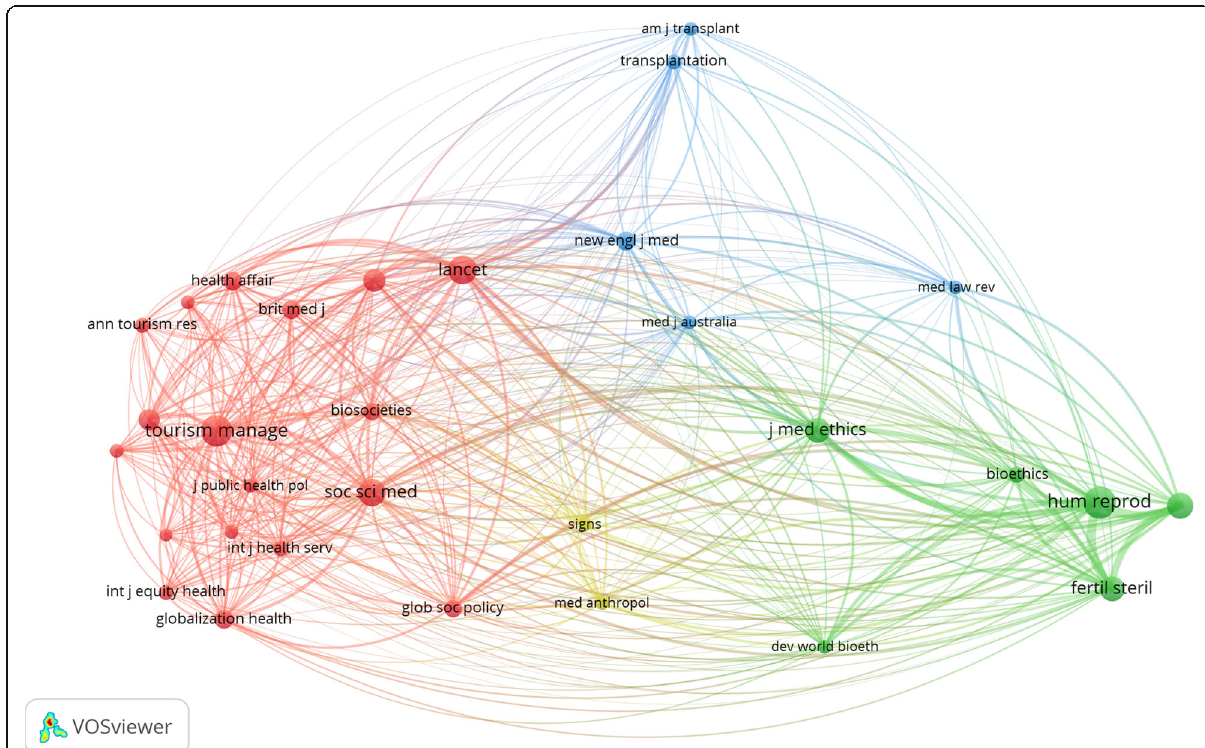
Fig. 10 Co-citation network of journals publishing policy research on medical tourism. Note: The figure shows how frequently journals (with at least 25 citations) are cited together in publications. Nodes depict journals and their linkages convey co-citation relationships. Larger nodes indicate journals with more citations. Link strengths indicate the frequency with which they are co-cited. Journals that are co-cited often are clustered together in nodes of the same